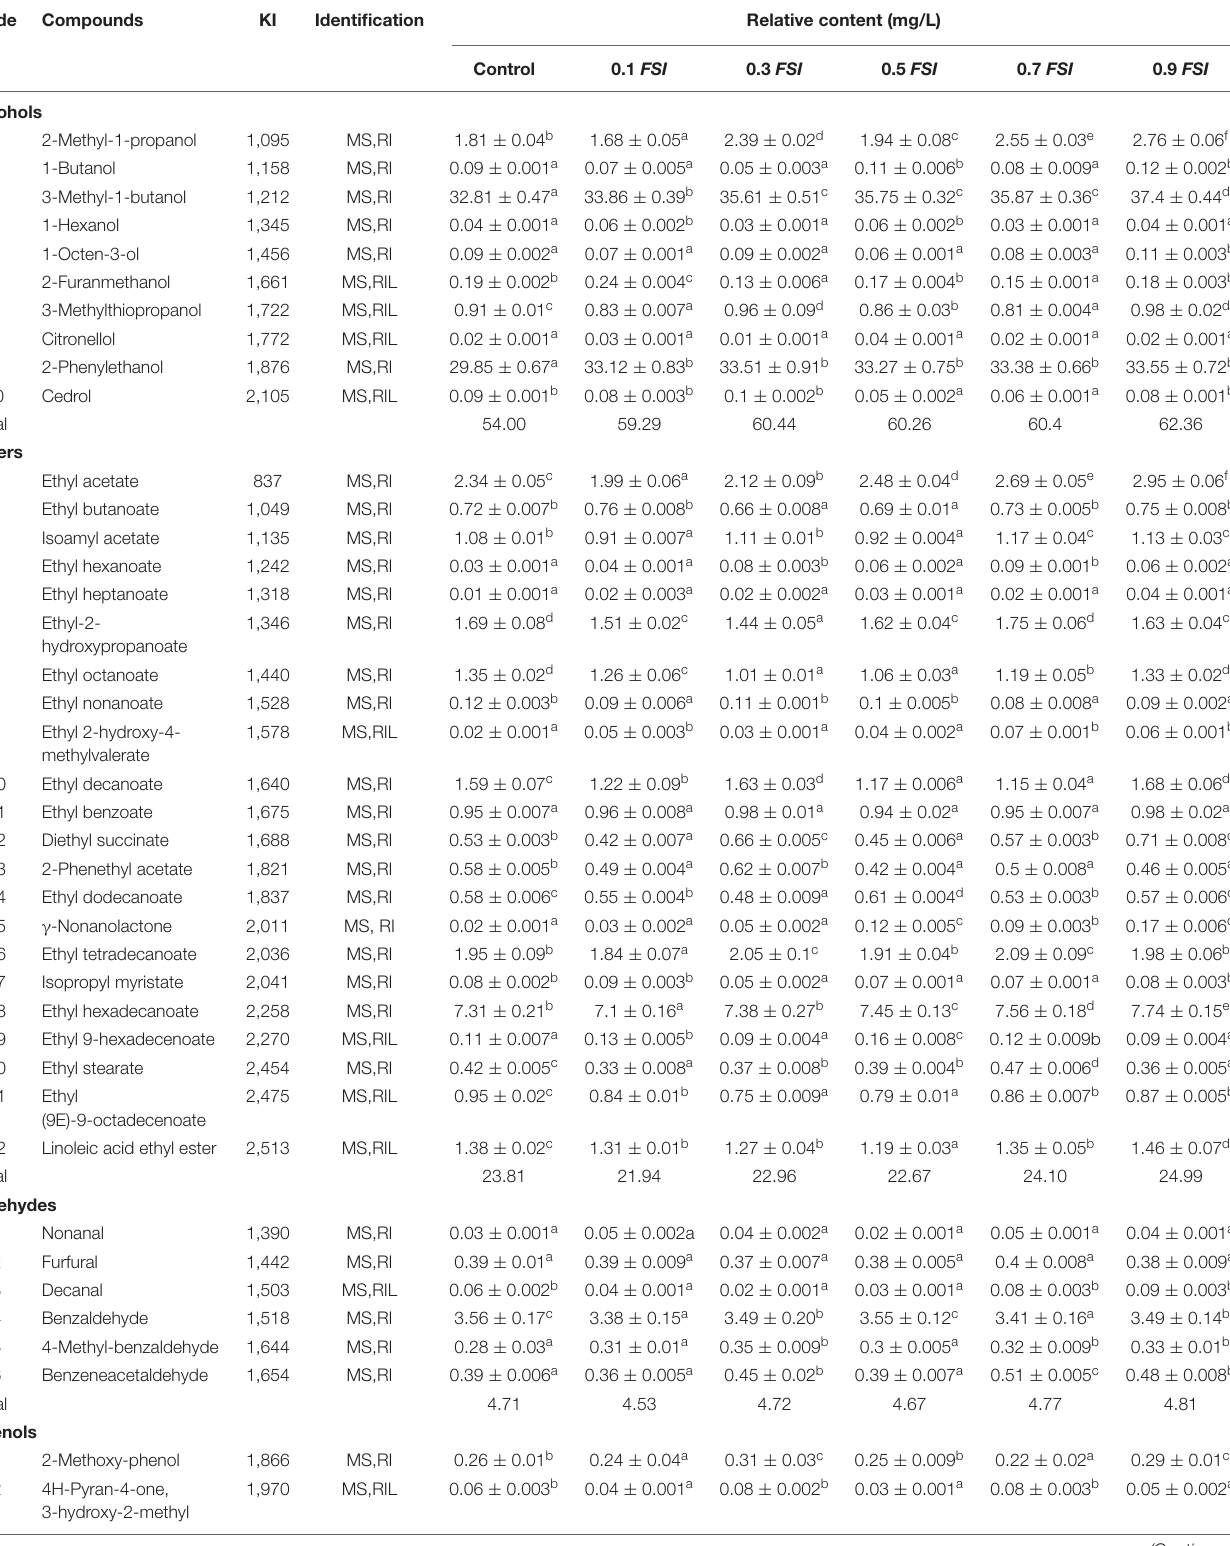
TABLE 1 | Identification and relative contents of volatile flavor compounds in aged HQW (160 d) containing with different concentrations of FSI . Code Compounds